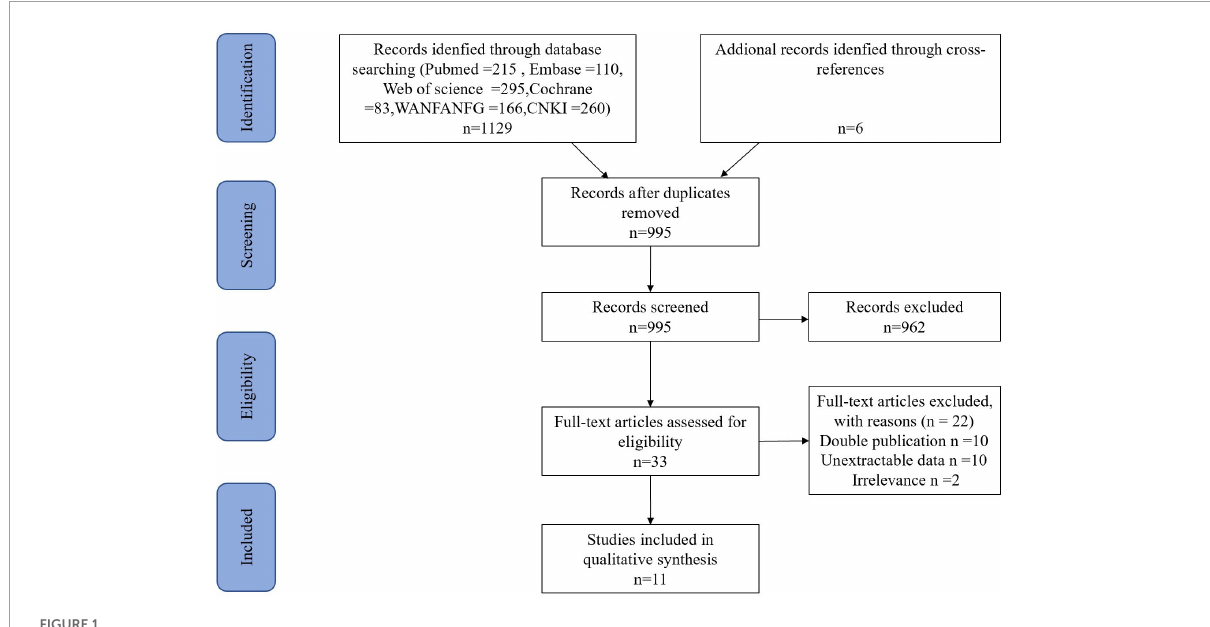
FIGURE1 Study flow